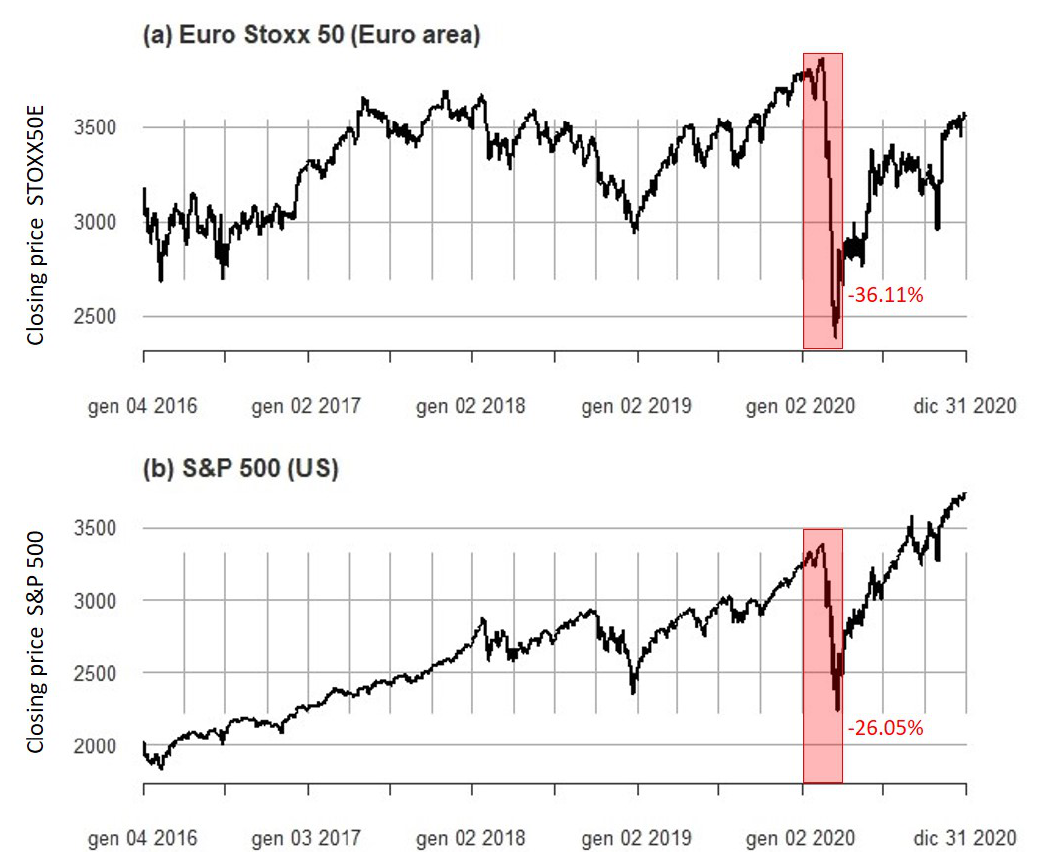
Figure 2. Time plot of daily closing prices (4 January 2016–31 December 2020). Panel ( a ) contains the daily closing prices of Euro Stoxx 50 (STOXX50E). Panel ( b ) contains the daily closing prices of S&P 500